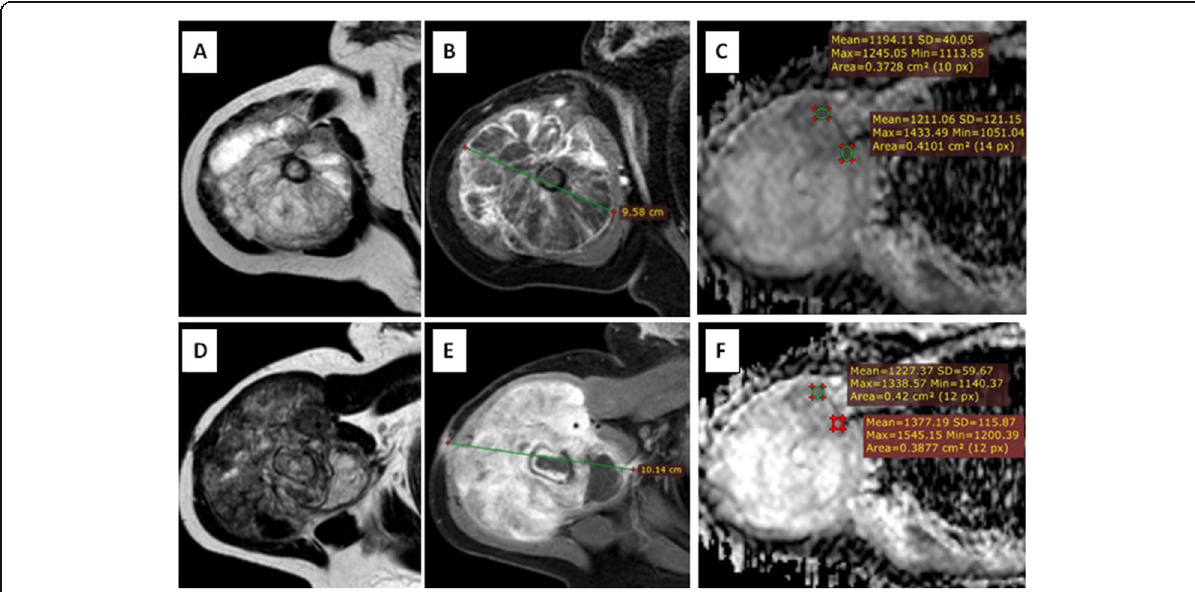
Fig. 5 A 18-year-old male with osteosarcoma in the right humerus. MR images a – c before and d – f after chemotherapy. a , b Axial T2-WI and contrast-enhanced T1-WI showing cortically based meta-diaphyseal mass lesion circumferentially surrounding the right humerus infiltrating its medulla all over the shaft. It elicits heterogeneous high signal in T2 with heterogeneous contrast uptake. c ADC map showed diffusion restriction with mean ADC values of the most restricted ROIs about (mean, 1.29 × 10 − 3 mm 2 /s). d , e Follow-up conventional axial T2 and post contrast showing size progression and more contrast enhancement. f Follow-up ADC mapping showed no significant interval changes (1.3 × 10 − 3 mm 2 /s)